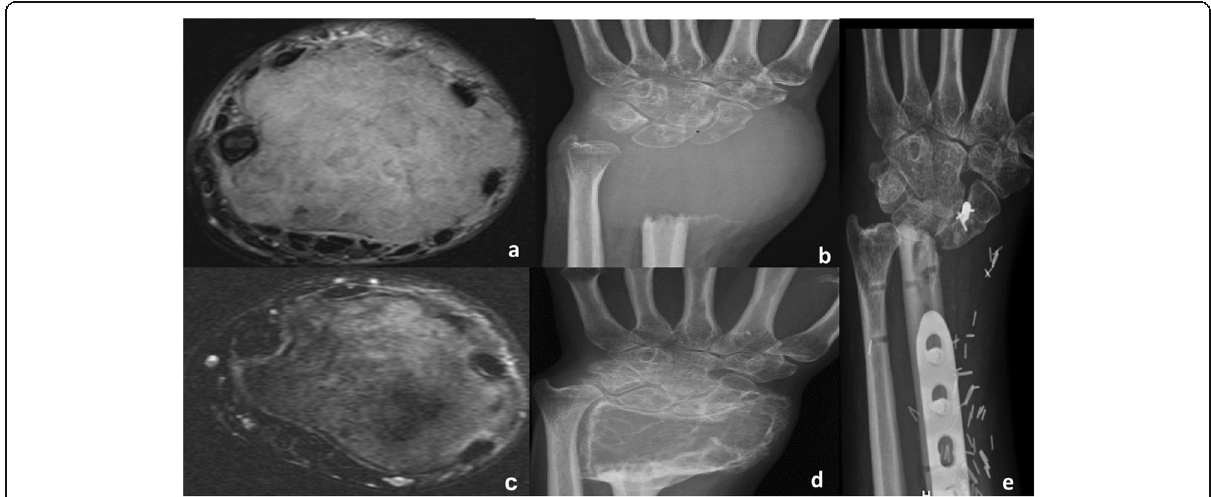
Fig. 4 A 30-year-old female with giant cell tumor of distal radius treated with resection. MRI ( a ) and AP radiograph ( b ) before treatment show locally aggressive lytic lesion with ambiguous borders and after treatment ( c , d ) reveal internal mineralization of the lytic areas and clear sclerotic margin. Postoperative AP radiograph ( e